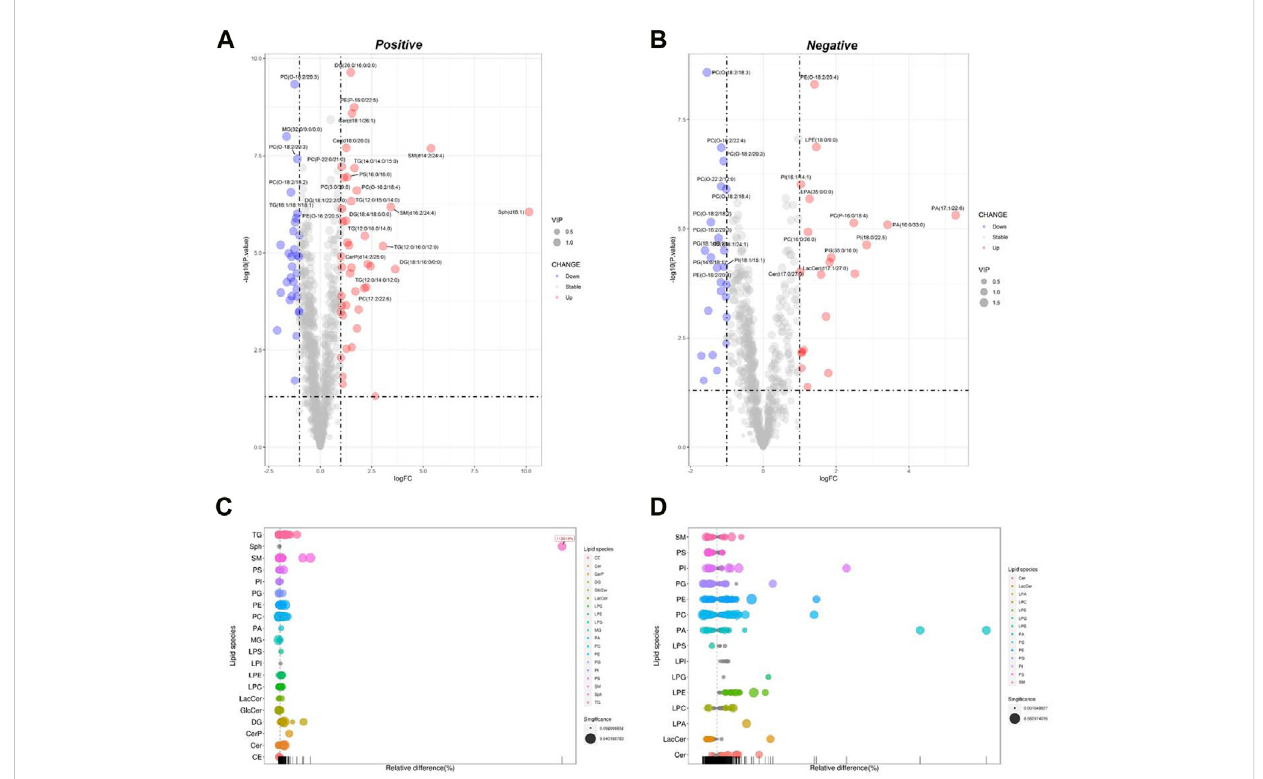
FIGURE 4 Analysis of signi fi cantly differential lipid substances in the Pal + DPA-EA group versus the Pal group. Volcano plots (A,B) and lipid plots (C,D) in both positiveandnegativeionmodes,respectively.Inthevolcanoplot,lipidspecieswerescreenedoutbasedonthecriteriaof p < 0.05,VIP ≥ 1,andfoldchange < 0.5 or >